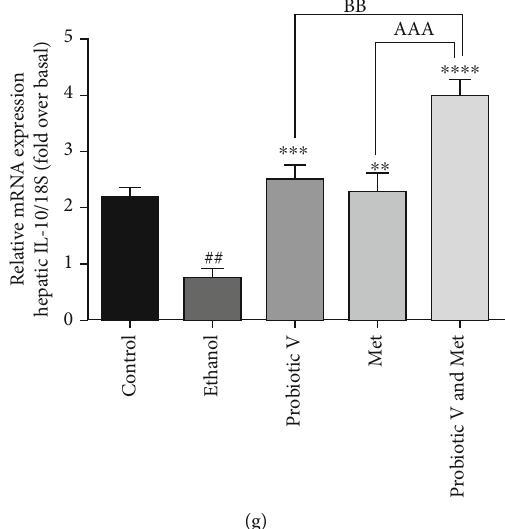
Figure 11: E ff ect of probiotic V or Met alone or in combination on ethanol-induced in fl ammatory response and oxidative stress. The in fl ammatory gene levels in the male Wistar rat liver are (a) CYP2E1, (b) TLR-4, (c) TNF- α , (d) IL-6, (e) HO-1, (f) Nrf-2, and (g) IL-10. Ethanol-fed rats were also treated with probiotic V (10 8 CFU/day) and Met (75 mg/kg) alone or together in combination for 25 days. At the end of the feeding protocol, liver tissue was collected, RNA was isolated, and qRT-PCR was performed to quantify the relative mRNA expression levels of the genes. Values are expressed as mean ± SD of six rats. Statistical signi fi cance was assessed by one-way ANOVA followed by Tukey post hoc test. Statistical analysis: # p < 0 : 05 and #### p < 0 : 0001 compared with control group; ∗ p < 0 : 05 , ∗∗ p < 0 : 01 , ∗∗∗ p < 0 : 0001 , and ∗∗∗∗ p < 0 : 0001 compared with ethanol group; A,B p < 0 : 05 , AA,BB p < 0 : 01 , AAA,BBB p < 0 : 001 , and AAAA,BBBB p < 0 : 0001 compared with probiotic V and Met combinatorial